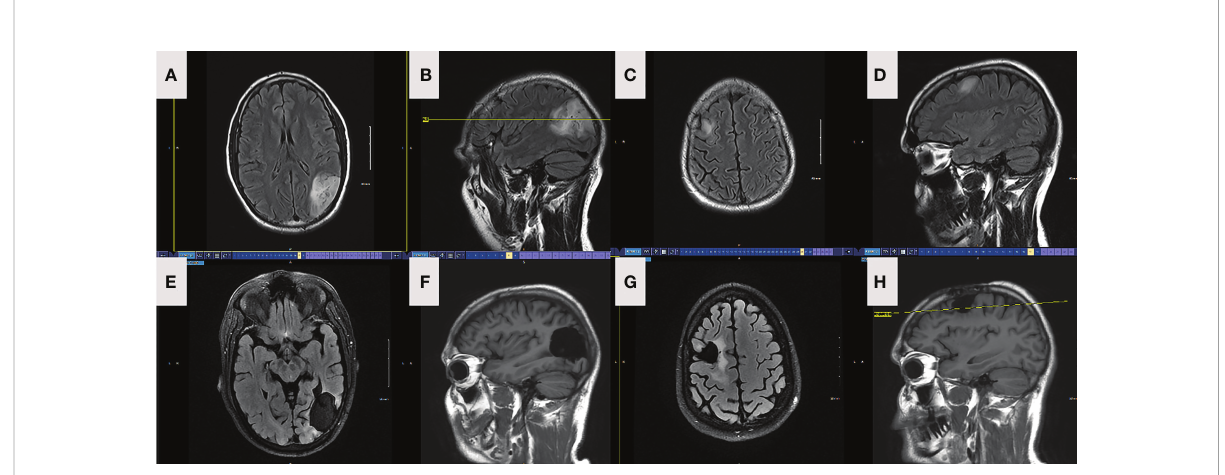
FIGURE 1 FLAIR axial (A) and sagittal (B) MRI depicting preop left parietal lesion in patient 1. FLAIR axial (C) and sagittal (D) MRI depicting preop right frontal lesion in patient 1. FLAIR axial (E) and sagittal (F) MRI depicting left parietal lesion and resection in patient 1, 18-month postoperatively. FLAIR axial (G) and sagittal (H) MRI depicting right frontal lesion and resection in patient 1, 18-month postoperatively.